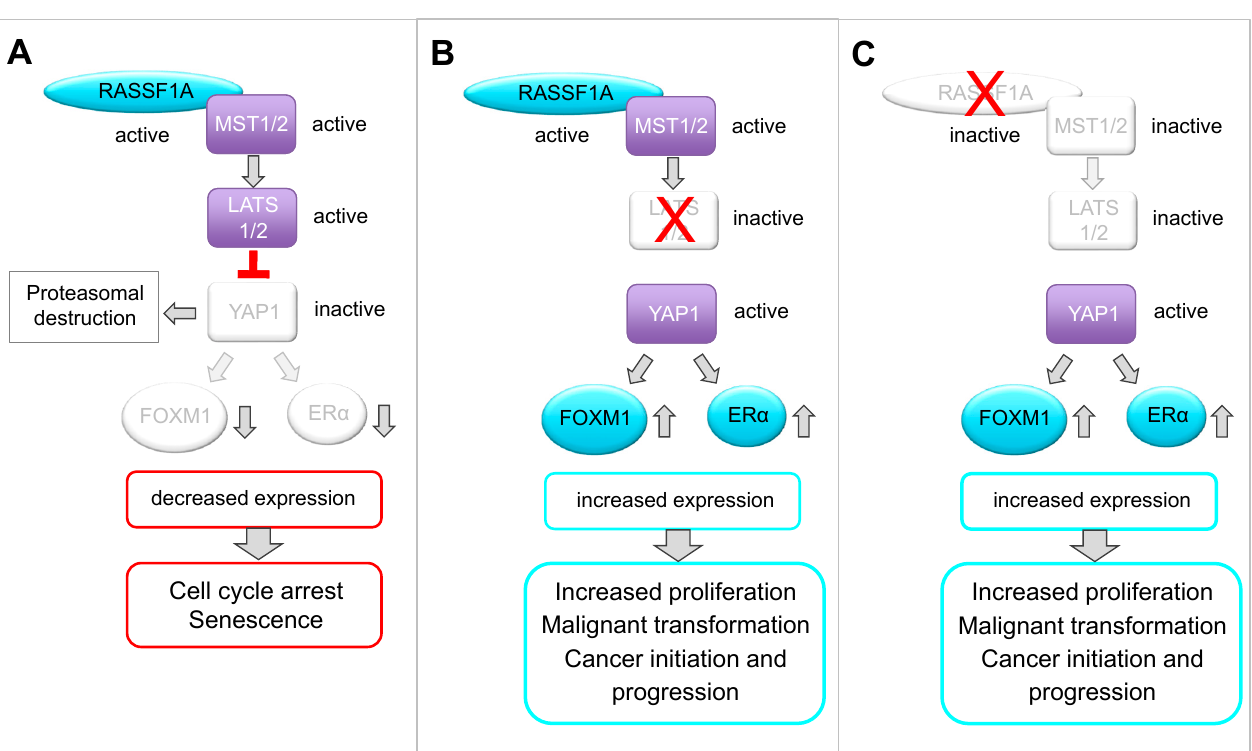
Figure 6. Schematic model of a possible molecular network between RASSF1A, the Hippo-kinases LATS1 and LATS2, the Hippo kinase effector YAP1, FOXM1 and ER α based on the findings in this paper and on the published